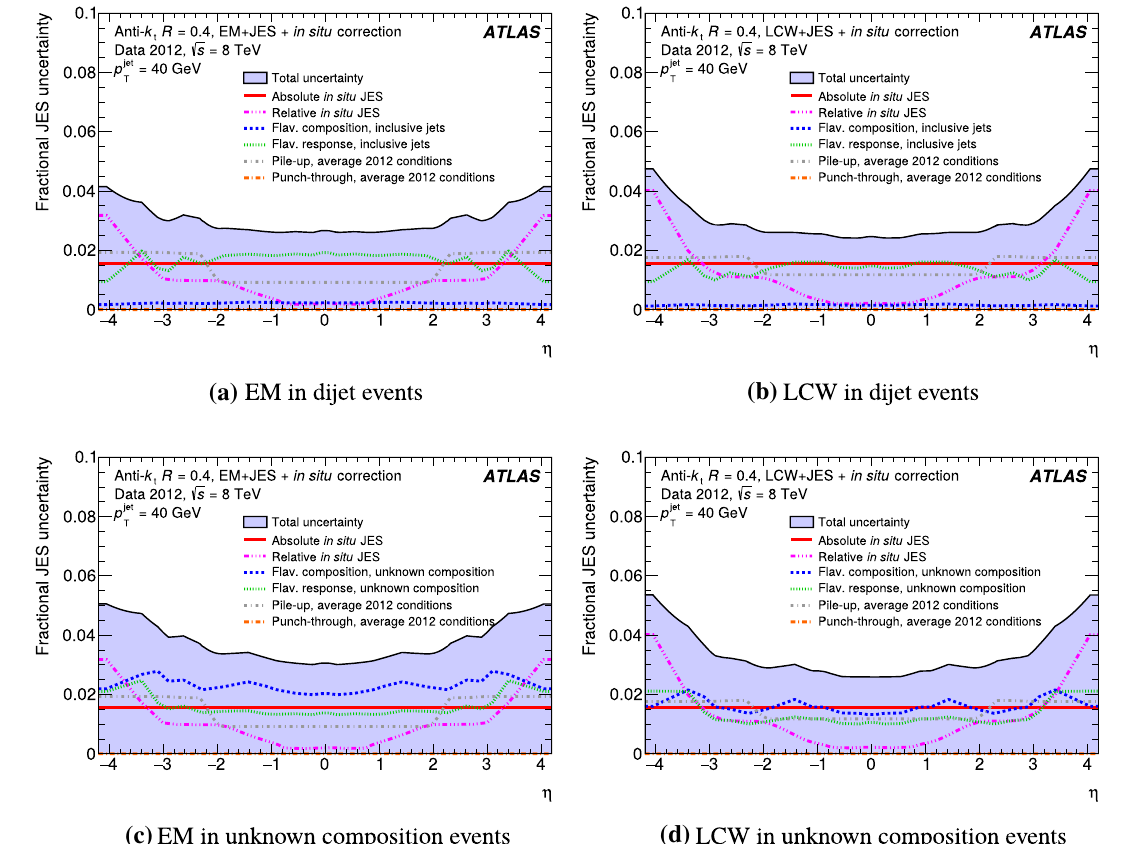
Fig. 42 The total jet energy scale uncertainty as a function of | η | for p T = 40 GeV jets. Two flavour compositions are shown, one for dijet events, where the quark/gluon composition is taken from MC simula- tions and an associated uncertainty from generator comparisons, and one for an unknown flavour composition (assuming 50:50 quark:gluon